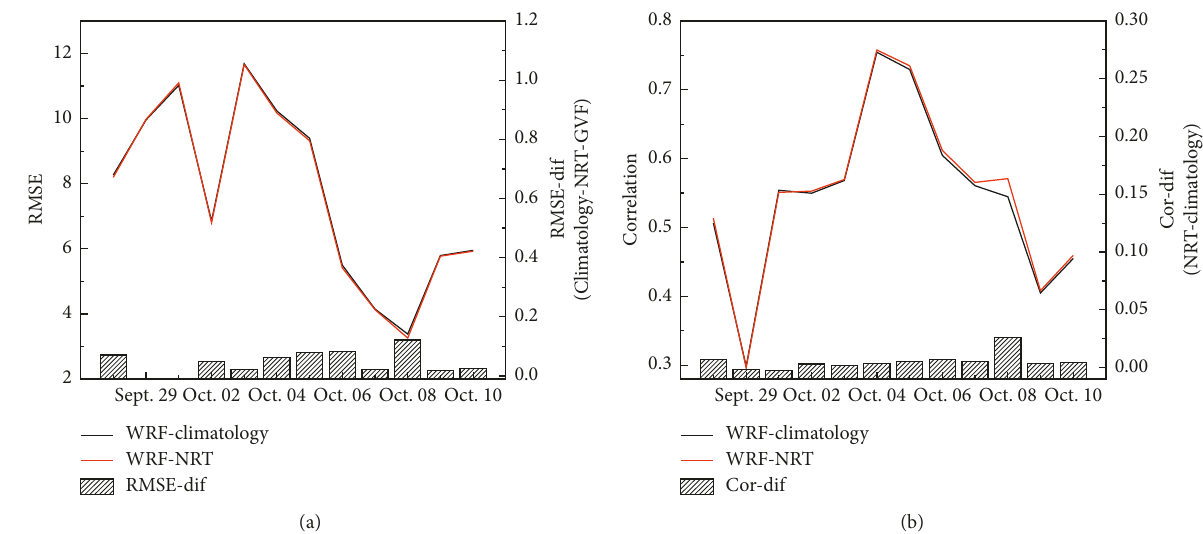
Figure 10: Comparison of RMSE (a) and correlation coefficient (b) of 24h accumulated precipitation forecasts from WRF runs using climatological and NRT GVF during 3 October–10 October